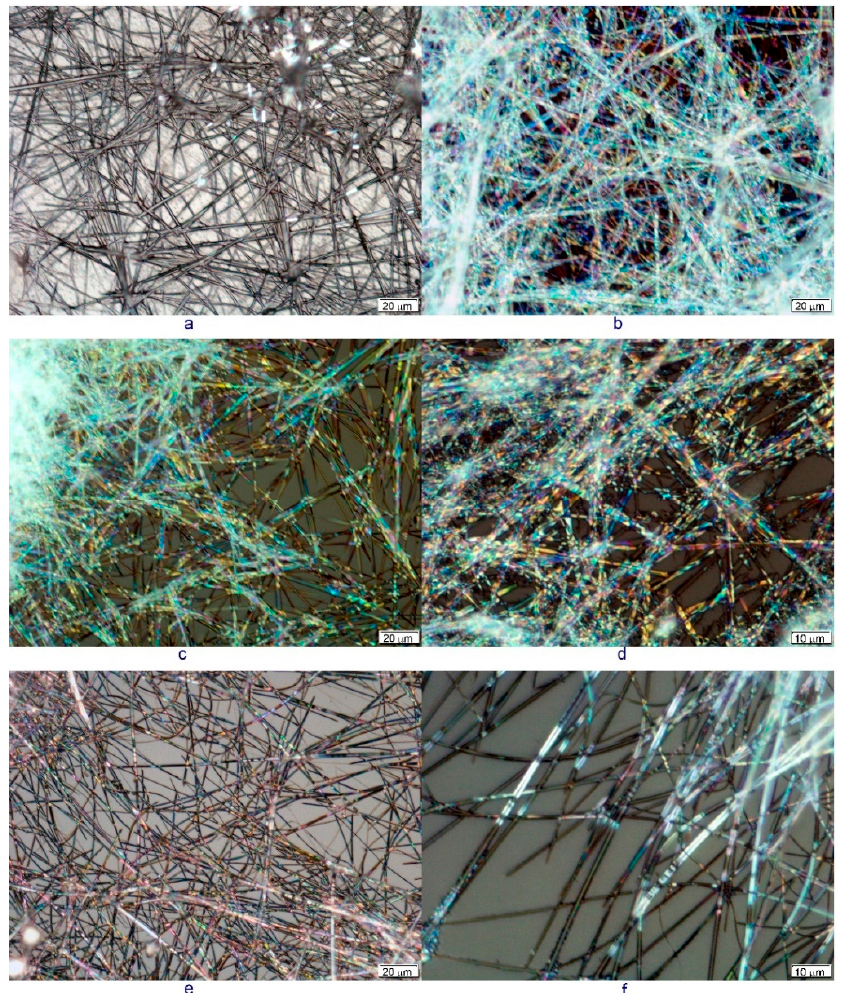
Figure 4. Optical micrographs of several gels formed by different gelators: ( a ) 7a in DMSO:H 2 O (1:1) at 4.0 mg/mL; ( b ) 7c in DMSO:H 2 O (1:1) at 3.3 mg/mL; ( c ) 7c in DMSO:H 2 O (1:2) at 4.0 mg/mL; ( d ) 7d in EtOH:H 2 O (1:1) at 3.3 mg/mL; ( e ) 7a and Ni(OAc) 2 ·4H 2 O (1.5 equiv of 7a ) in DMSO:H 2 O (1:5) at 5.0 mg/mL, ( f ) 7a and Zn(OAc) 2 ·2H 2 O (1.5 equiv of 7a ) in DMSO:H 2 O (1:5) at 4.3 mg/mL.